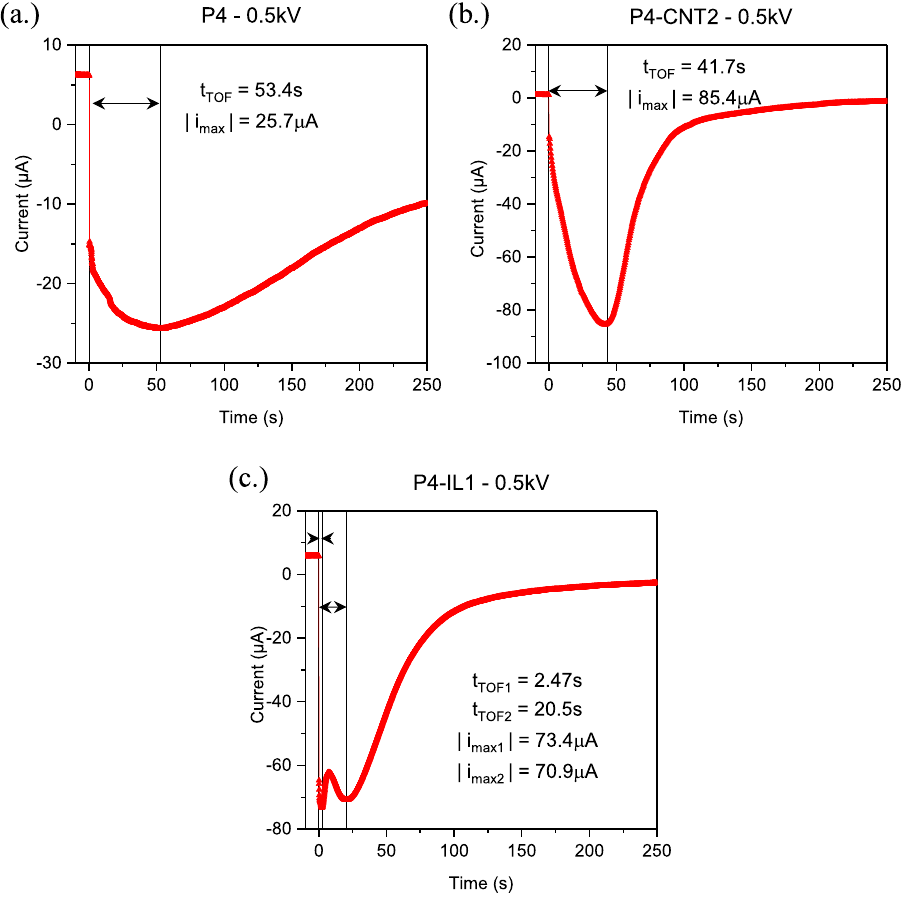
Figure 4. ( a ) i-t plot for a 0.5 kV voltage polarity reversal in P4, ( b ) P4-CNT2, and ( c )